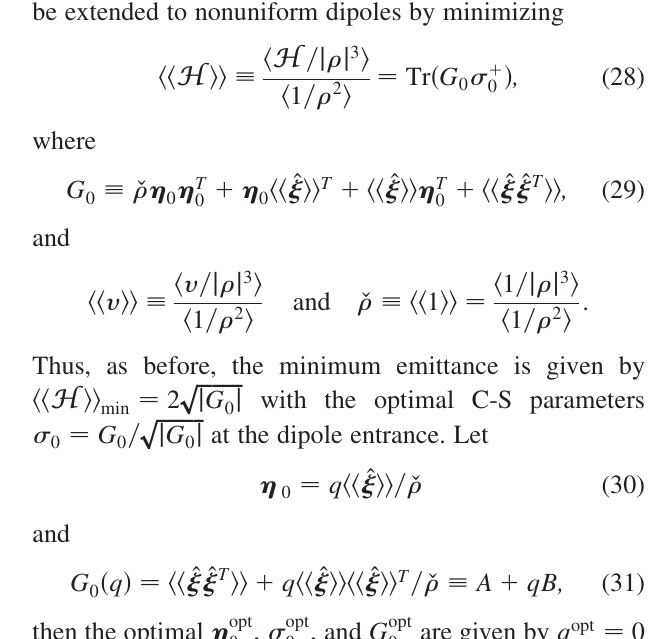
FIG. 1. Contours of emittance degradation due to nonoptimal Courant-Snyder parameters at the dipole